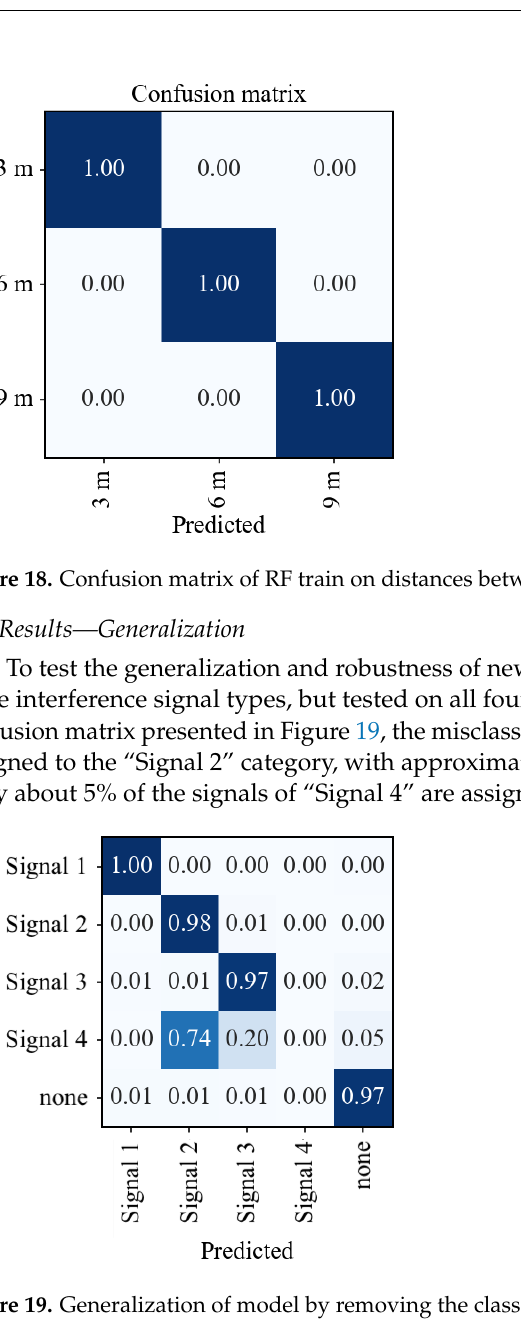
Figure 19. Generalization of model by removing the class “Signal 4” in the training